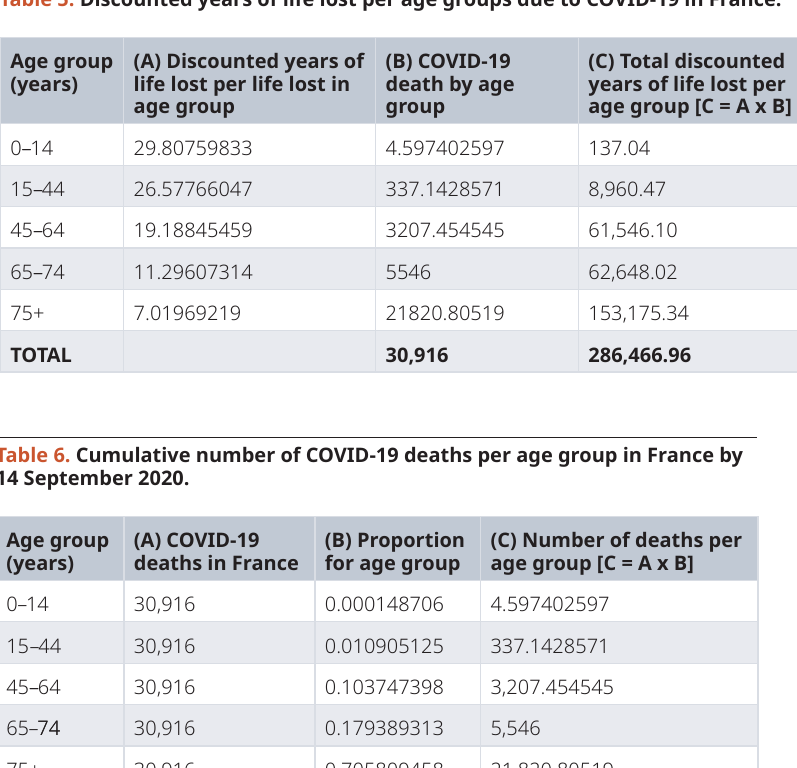
Table 5. Discounted years of life lost per age groups due to COVID-19 in France.